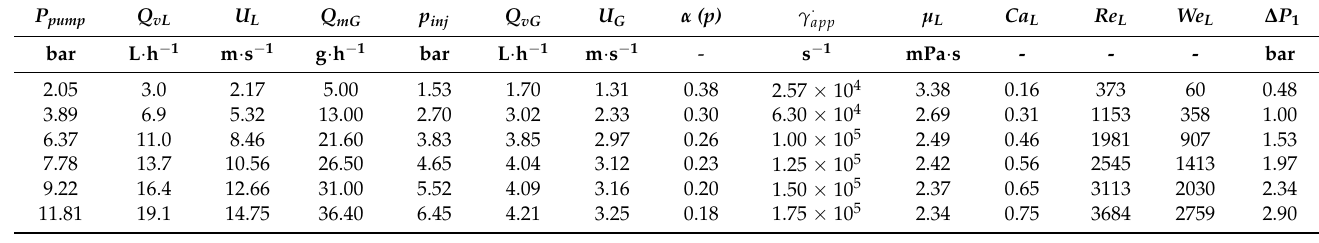
Figure 5. Tip-streaming bubble breakup mechanism identified in the mixing channel of all devices. Visualizations with the device CX600 at a liquid flowrate of 11 L/h. Liquid phase: model solution WPI3XG04. Gas phase: N 2 . At the bottom left: enlarged view of a bubble and its schematic represen- tation. In the photos, a filament (circled in green) is shown before and after its break-up into satellite droplets; an interval of 0.18s had elapsed between the two pictures.